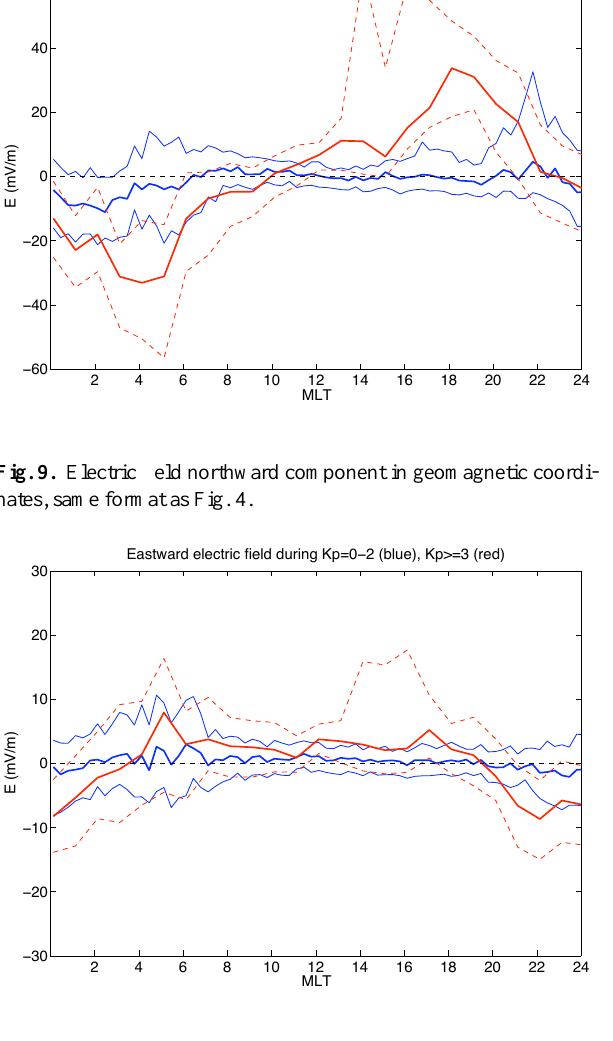
Fig. 10. Electric field eastward component in geomagnetic coordi- nates, same format as Fig. 4.